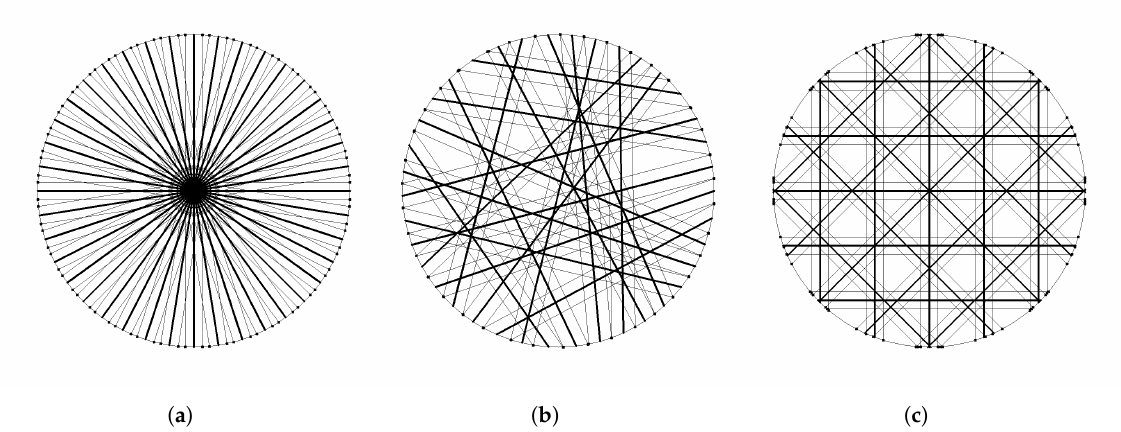
Figure 4. Multi-path measurement system: In order to gain maximum information out of the 20 optical beams, the geometrical arrangement is varied. ( a ) shows the worst case as the baseline for reconstruction error. ( b ) shows the result of an optimization algorithm in order to reduce the reconstruction error. ( c ) shows the chosen arrangement that is mechanically